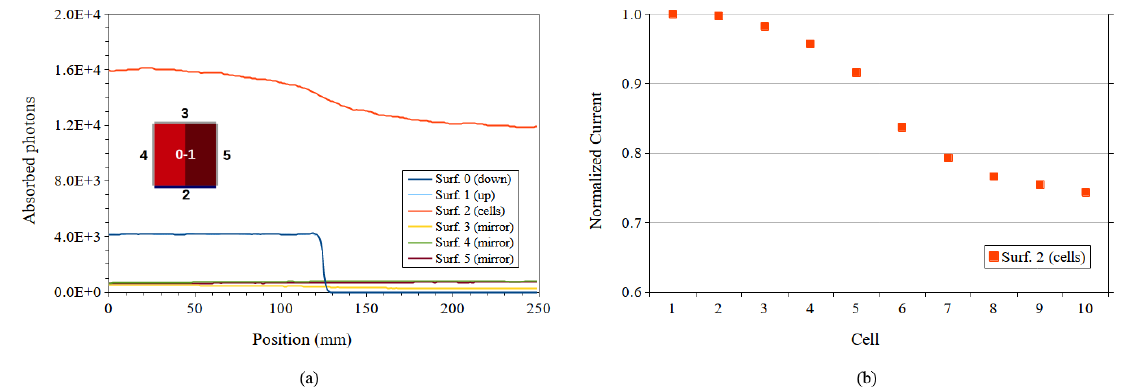
Figure 14. Shaded LSC panel with one 10-cells PV array, shading across the PV array: ( a ) Number of rays of light collected by the PV cells as a function of the position along the LSC side, which ranges from 0 mm to 250 mm. ( b ) Normalized current produced by each PV cell.